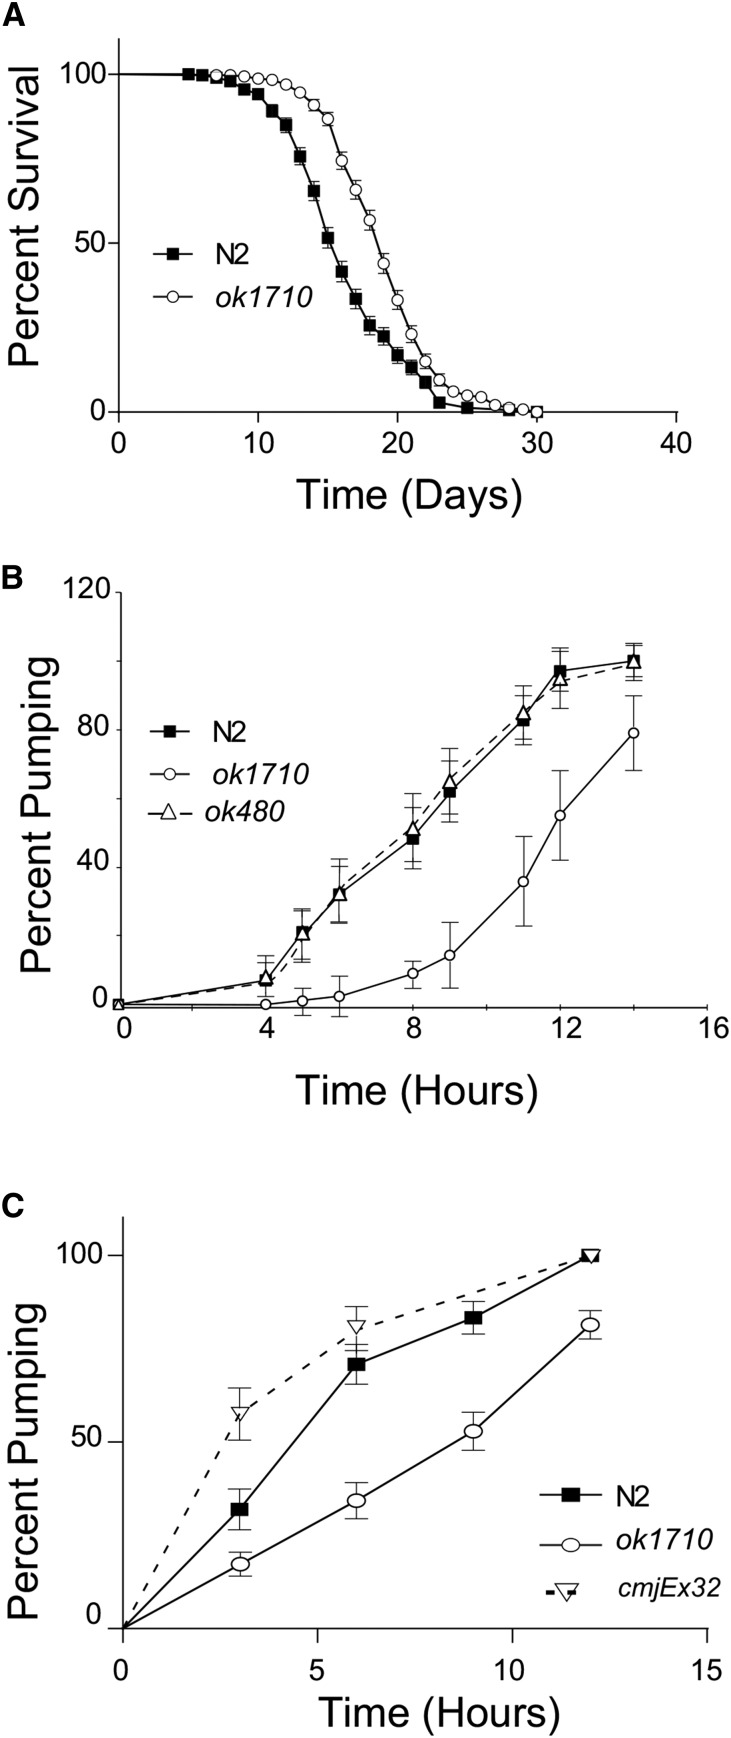
HLH-25 regulates lifespan and dauer recovery. (A) hlh-25(ok1710) animals (n = 282) have longer than lifespans than wild-type animals (n = 264, P-value < 0.0001). (B) Representative experiment showing the percentage of animals with pharyngeal pumping during dauer recovery at 20°. P-value < 0.0001 and P-value = 0.938 when hlh-25(ok1710) animals and daf-18(ok480) animals, respectively, were compared with wild-type. (C) Representative experiment showing the percentage of animals with pharyngeal pumping during dauer recovery at 20°. P-value < 0.0001 and P-value = 0.2771 when hlh-25(ok1710) and hlh-25(ok1710;cmjEx32) animals, respectively, were compared with wild-type.